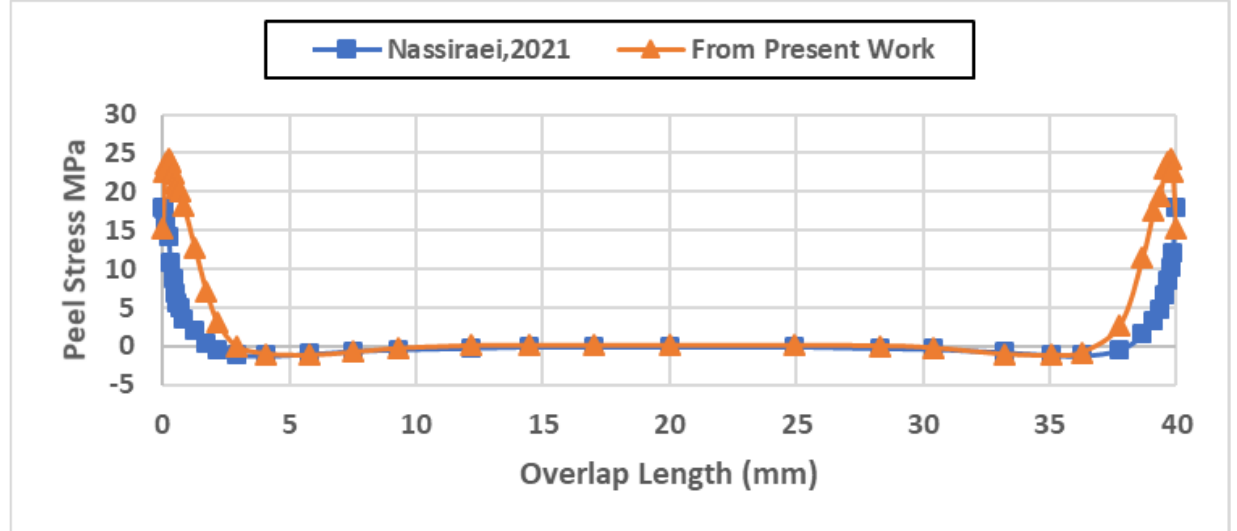
Figure 5. Validation of numerical model [36].